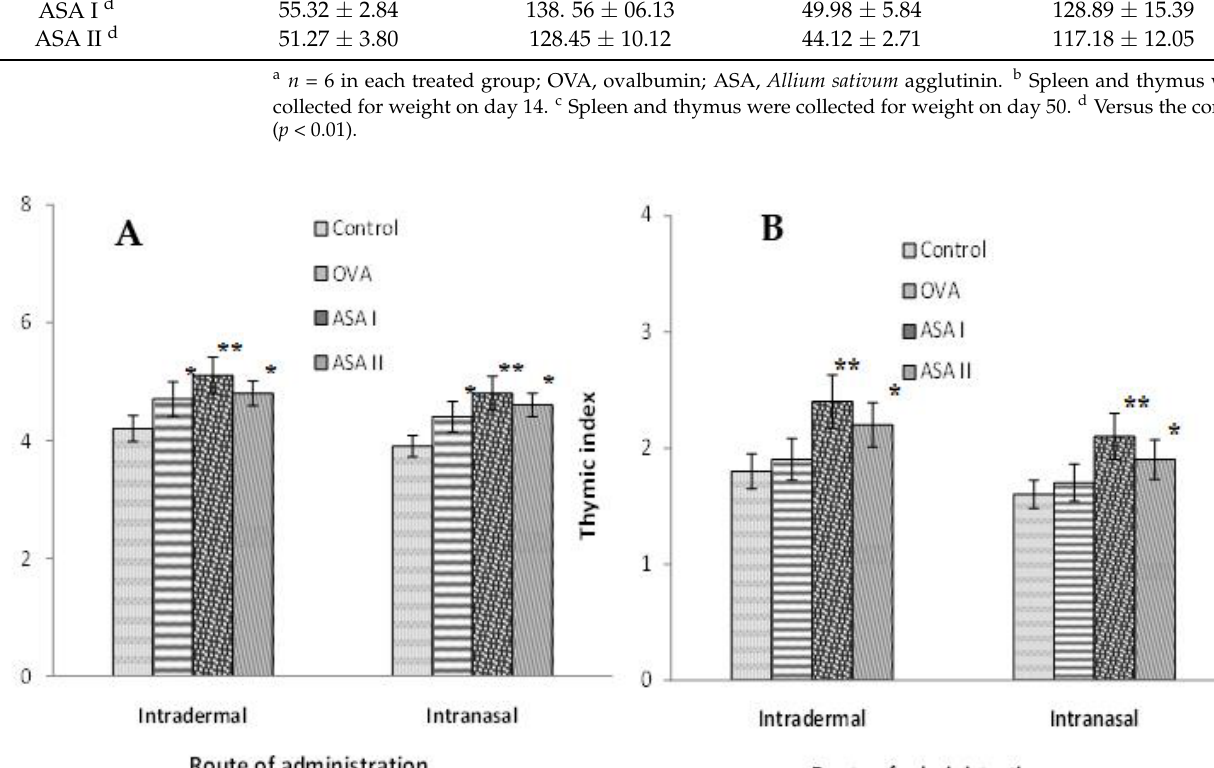
Figure 5. Splenic and thymic indices were measured in the control and test experimental groups after intranasal and intradermal immunization of OVA and garlic lectins in BALB/c mice. ( A ): Splenic index values for OVA, ASA I, or ASA II experimental groups on intradermal or intranasal administration of antigens. Spleen was collected on day 14 for intradermal groups and on day 50 for intranasal groups. Each value is represented as mean ± S.D. ( n = 6); * p < 0.05; ** p < 0.01. ( B ): Thymic index values for OVA, ASA I, or ASA II experimental groups by intradermal or intranasal routes of antigen administration. Thymus was collected on day 14 for intradermal groups and on day 50 for intranasal groups. Table 3. Weights of spleen and thymus of BALB/c mice by intradermal (i.d.) and intranasal (i.n.) administration of antigen (OVA, ASA I and II) samples.